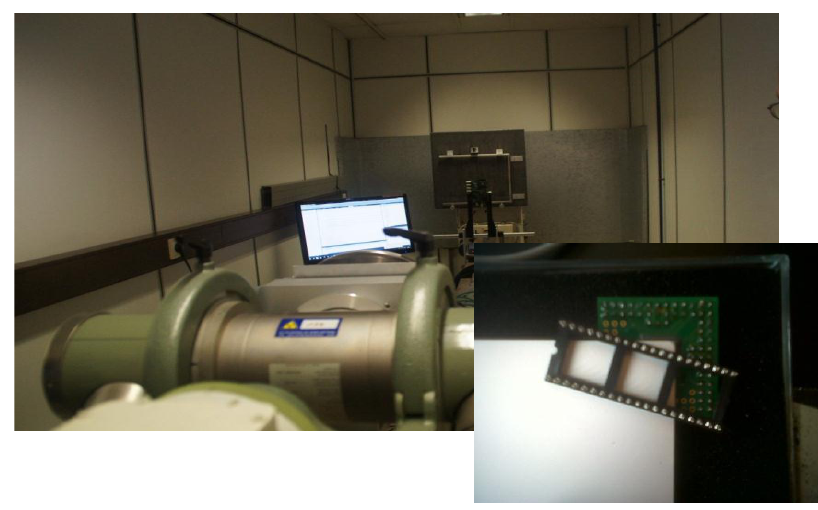
Figure 10. Photograph of an in-beam measurement setup.